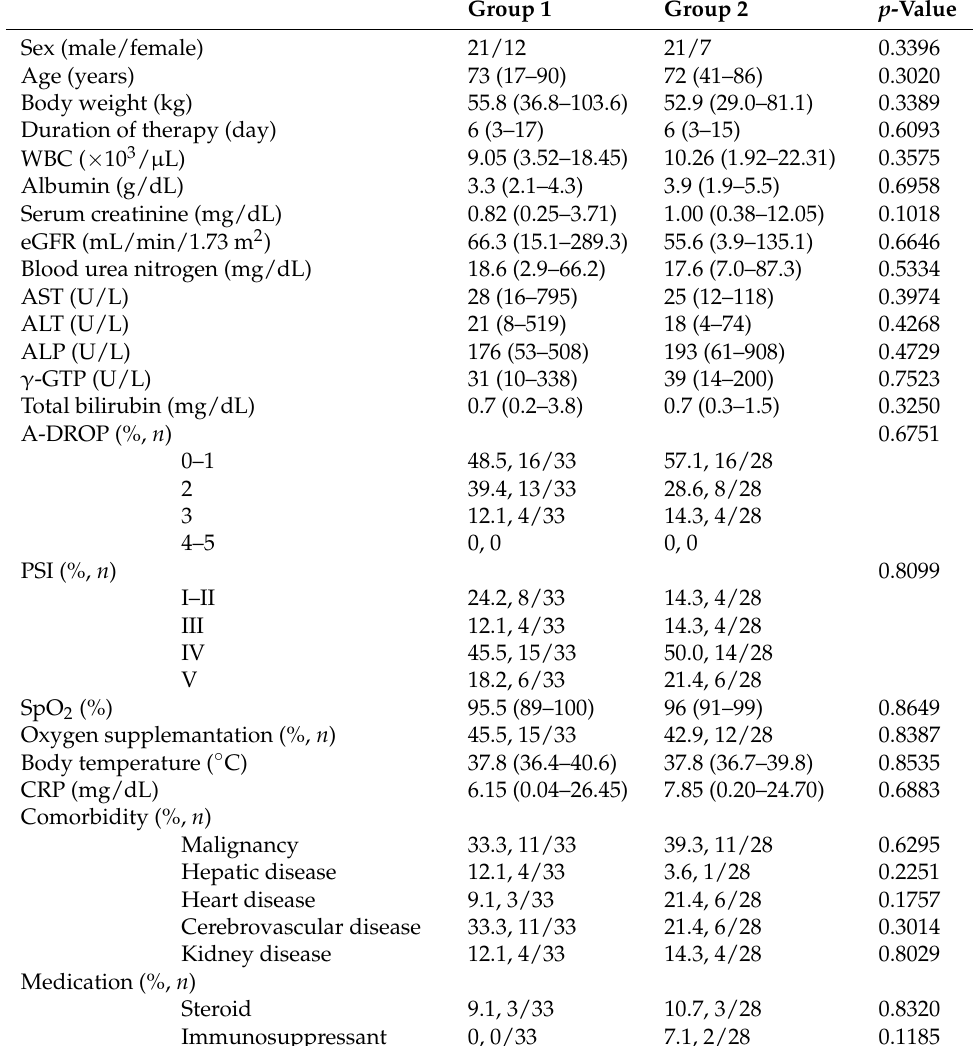
Table 1. Clinical Characteristics of Registered Patients.